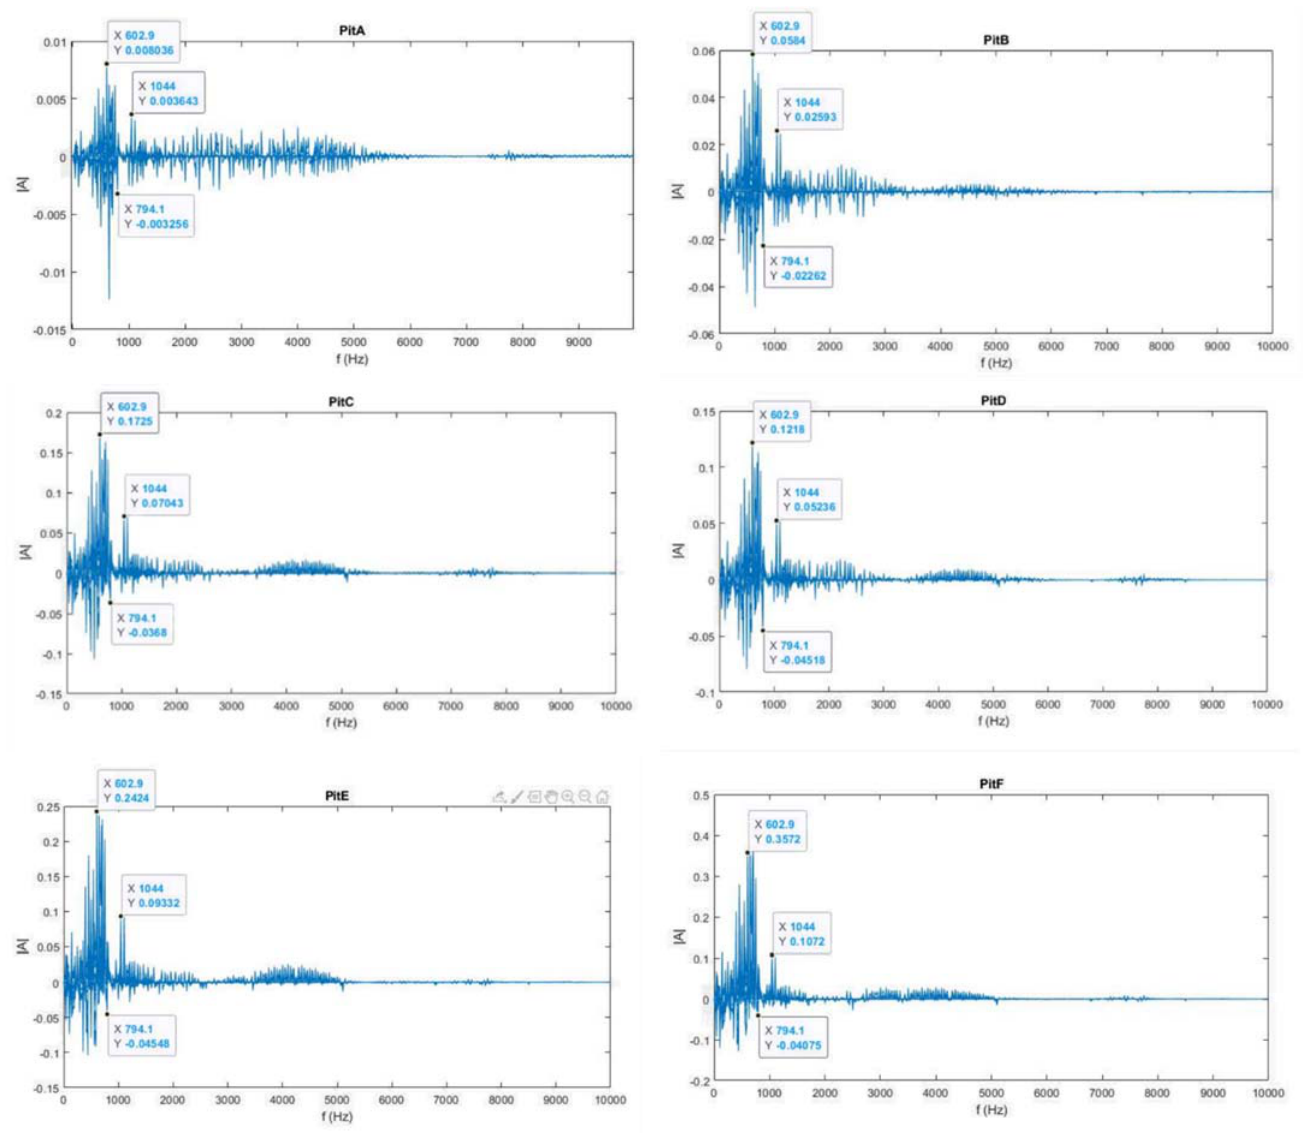
Figure 11. Differential spectra for different damage levels.